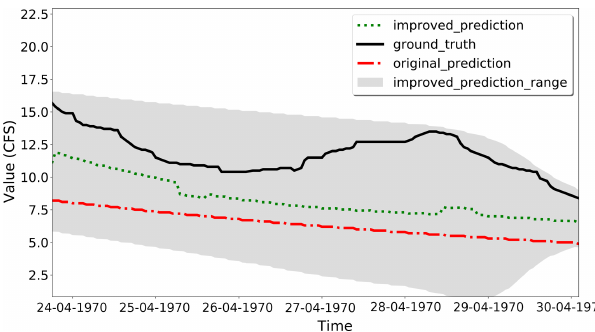
Figure 12. Case Study 2, HEC-HMS PRMS model improvements. The improved predictions are closer to the ground truth than the original